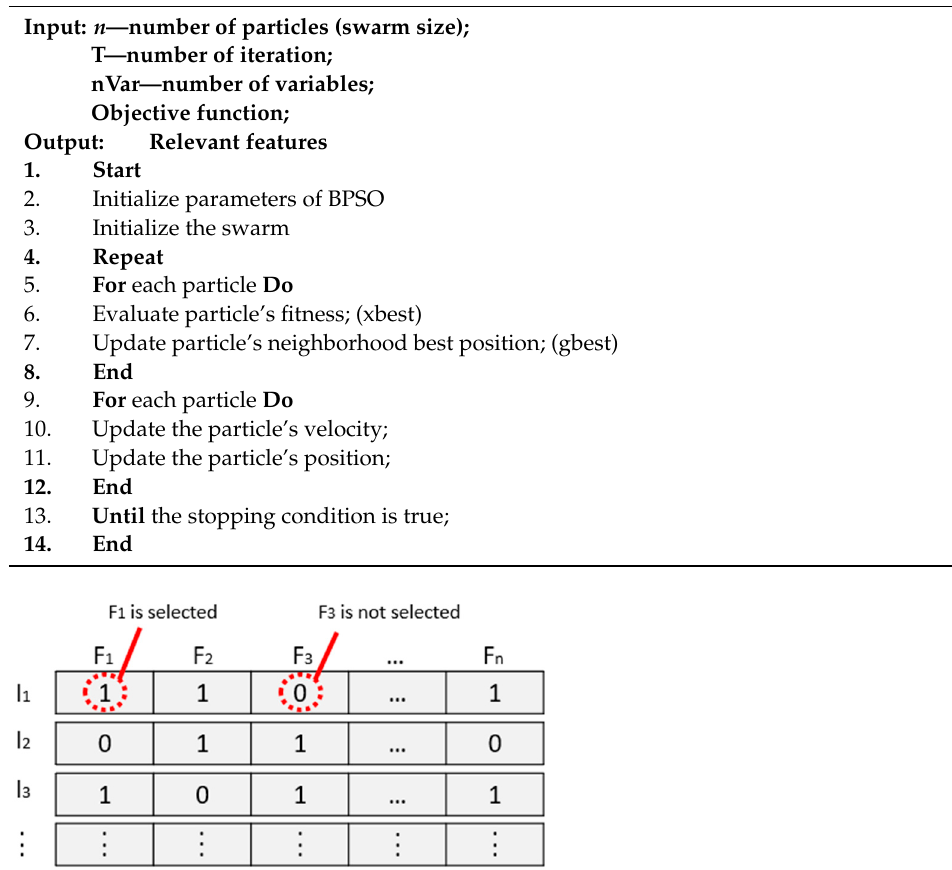
Algorithm 1: Pseudocode BPSO in Feature Selection.